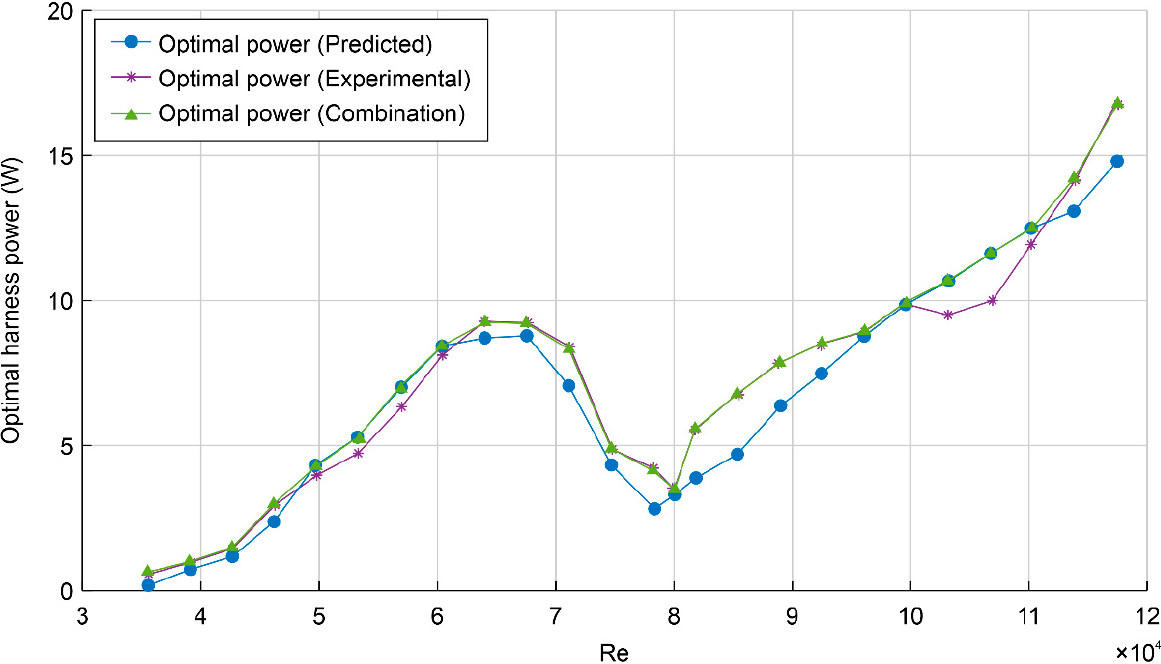
Figure 16. Optimal power envelope for the predicted, experimental, and combination curves.